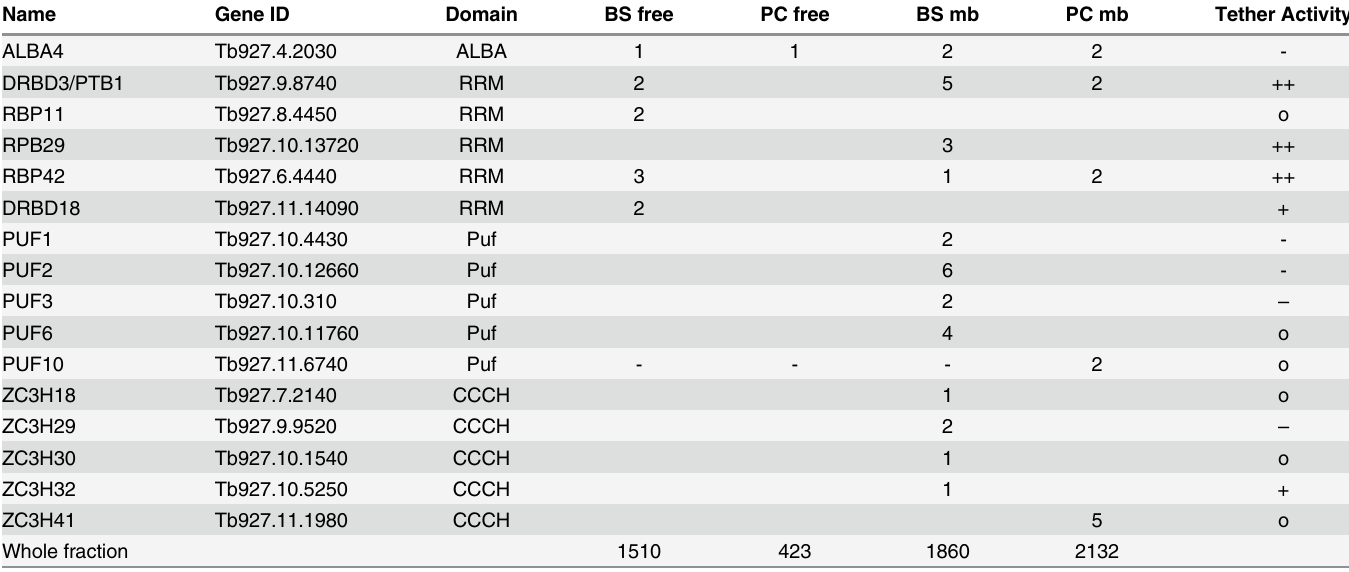
Table 1. RNA binding proteins found in polysomal fractions. The numbers of peptides detected in each preparation are shown for all identified proteins with RNA-binding domains. The proteins are arranged in alphabetical and numerical order. mb = membrane-bound. Activity after tethering to reporter mRNAs [19] is denoted as ++ for a reliable increase in expression (satisfying stringent criteria as defined in [19]), + for a moderate increase, — for clear decrease and — for mild decrease; o = no effect.